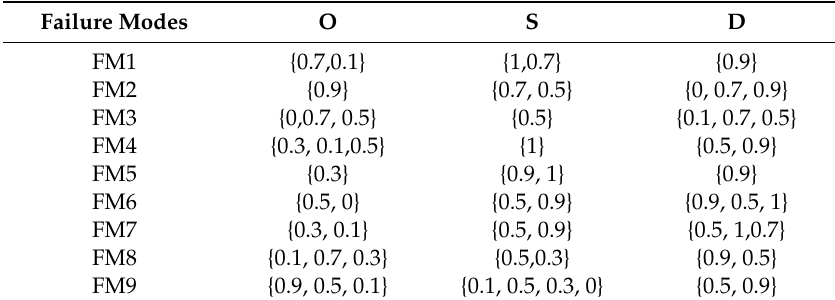
Table 8. Hesitant fuzzy decision matrix (numeric